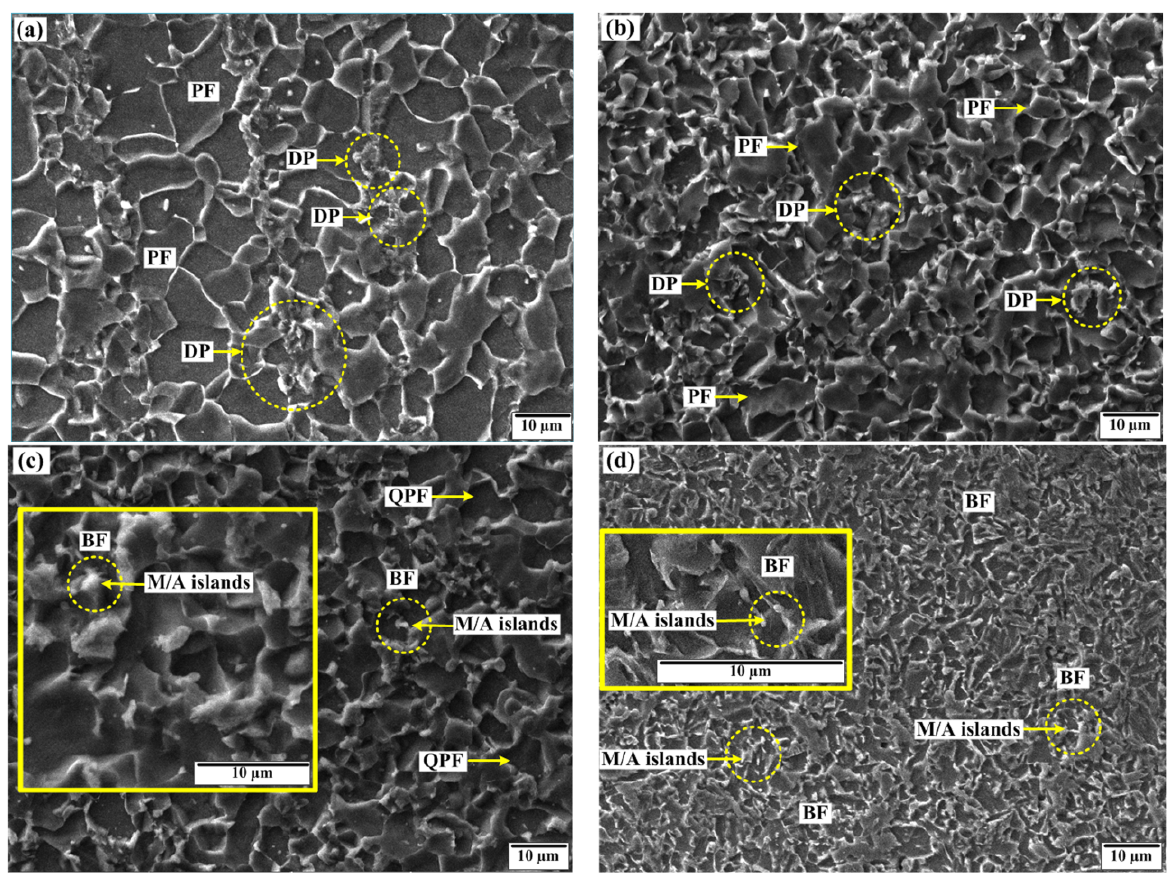
Figure 4: SEM micrographs indicating the microstructural features of weld simulated API 5L X-60 pipeline steel samples under different cool- ing rates: (a) 0.3; (b) 10; (c) 50; and (d) 360 ∘ C/s. Degenerate pearlite, polygonal ferrite, quasi-polygonal ferrite, plate-like bainitic ferrite, and martensite/austenite island microconstituents are marked in the figures with DP, PF, QPF, BF, and M/A islands symbols,